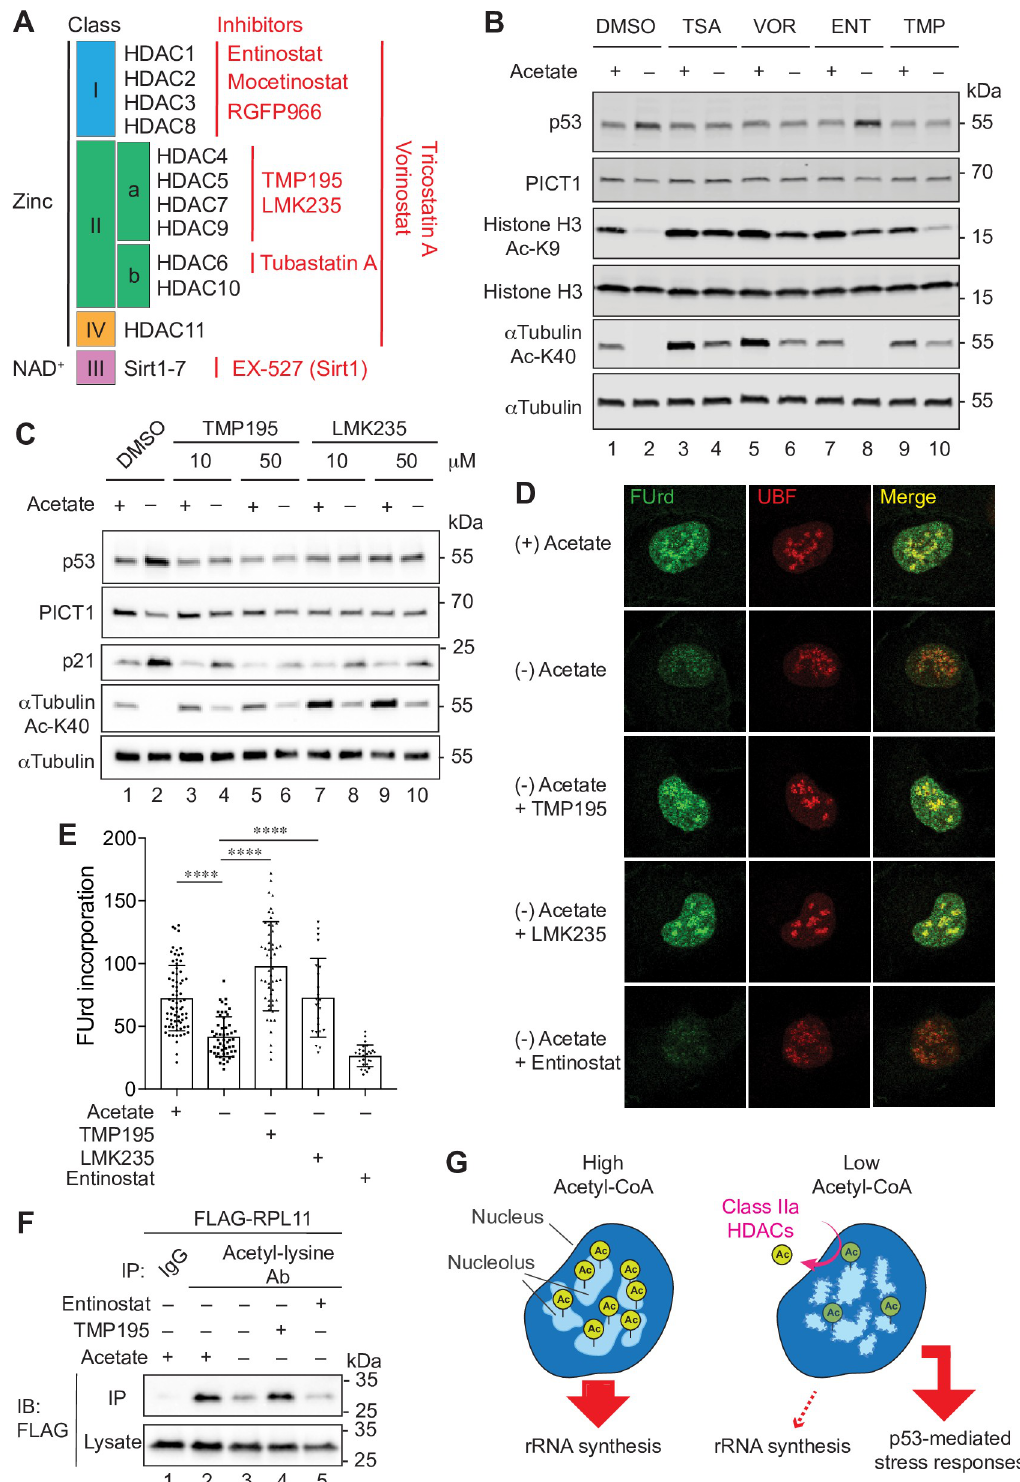
Fig 5. Class IIa HDAC activity is required for acetyl-CoA–induced nucleolar stress responses. (A) Schematic representation of mammalian HDAC family members and their inhibitors (red). (B) Immunoblotting for the indicated proteins in ASA-KO cells cultured in 1% FBS containing media with or without acetate, and in the presence or absence of indicated HDAC inhibitors for 4 hours. Following concentrations of HDAC inhibitors were used: 500-nM TSA, 10- μ M VOR, 70- μ M ENT,